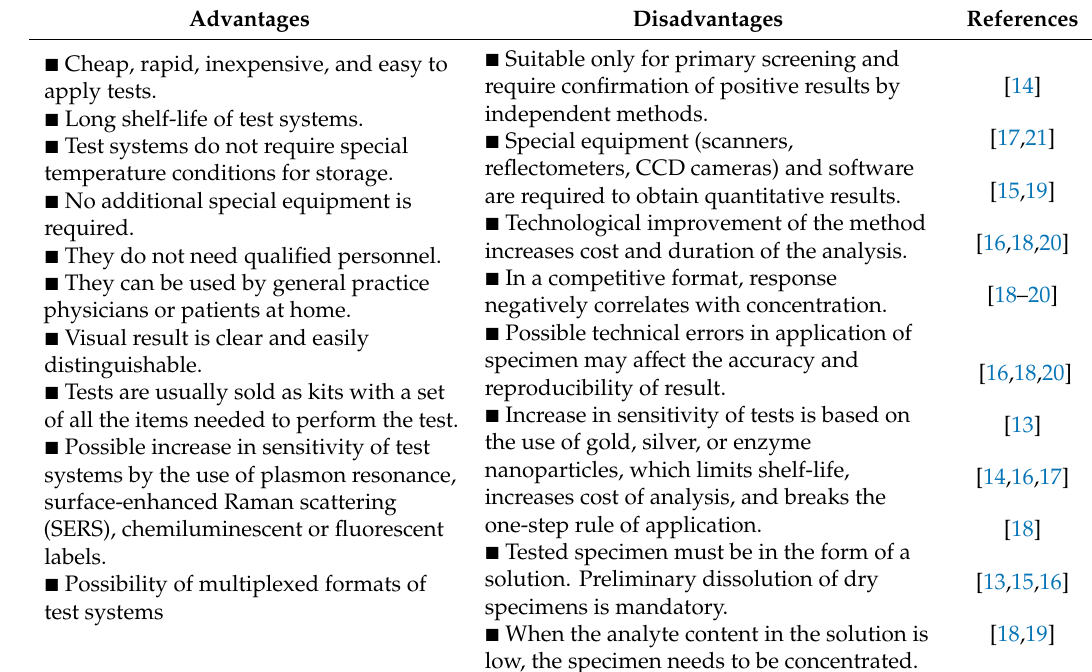
Figure 1. Schematic representation of the side-stream immunoassay mechanism lateral flow immunoassay (LFIA). Table1. Advantagesanddisadvantagesoftest-systemsbasedonthelateralflowimmunoassayplatform. Advantages